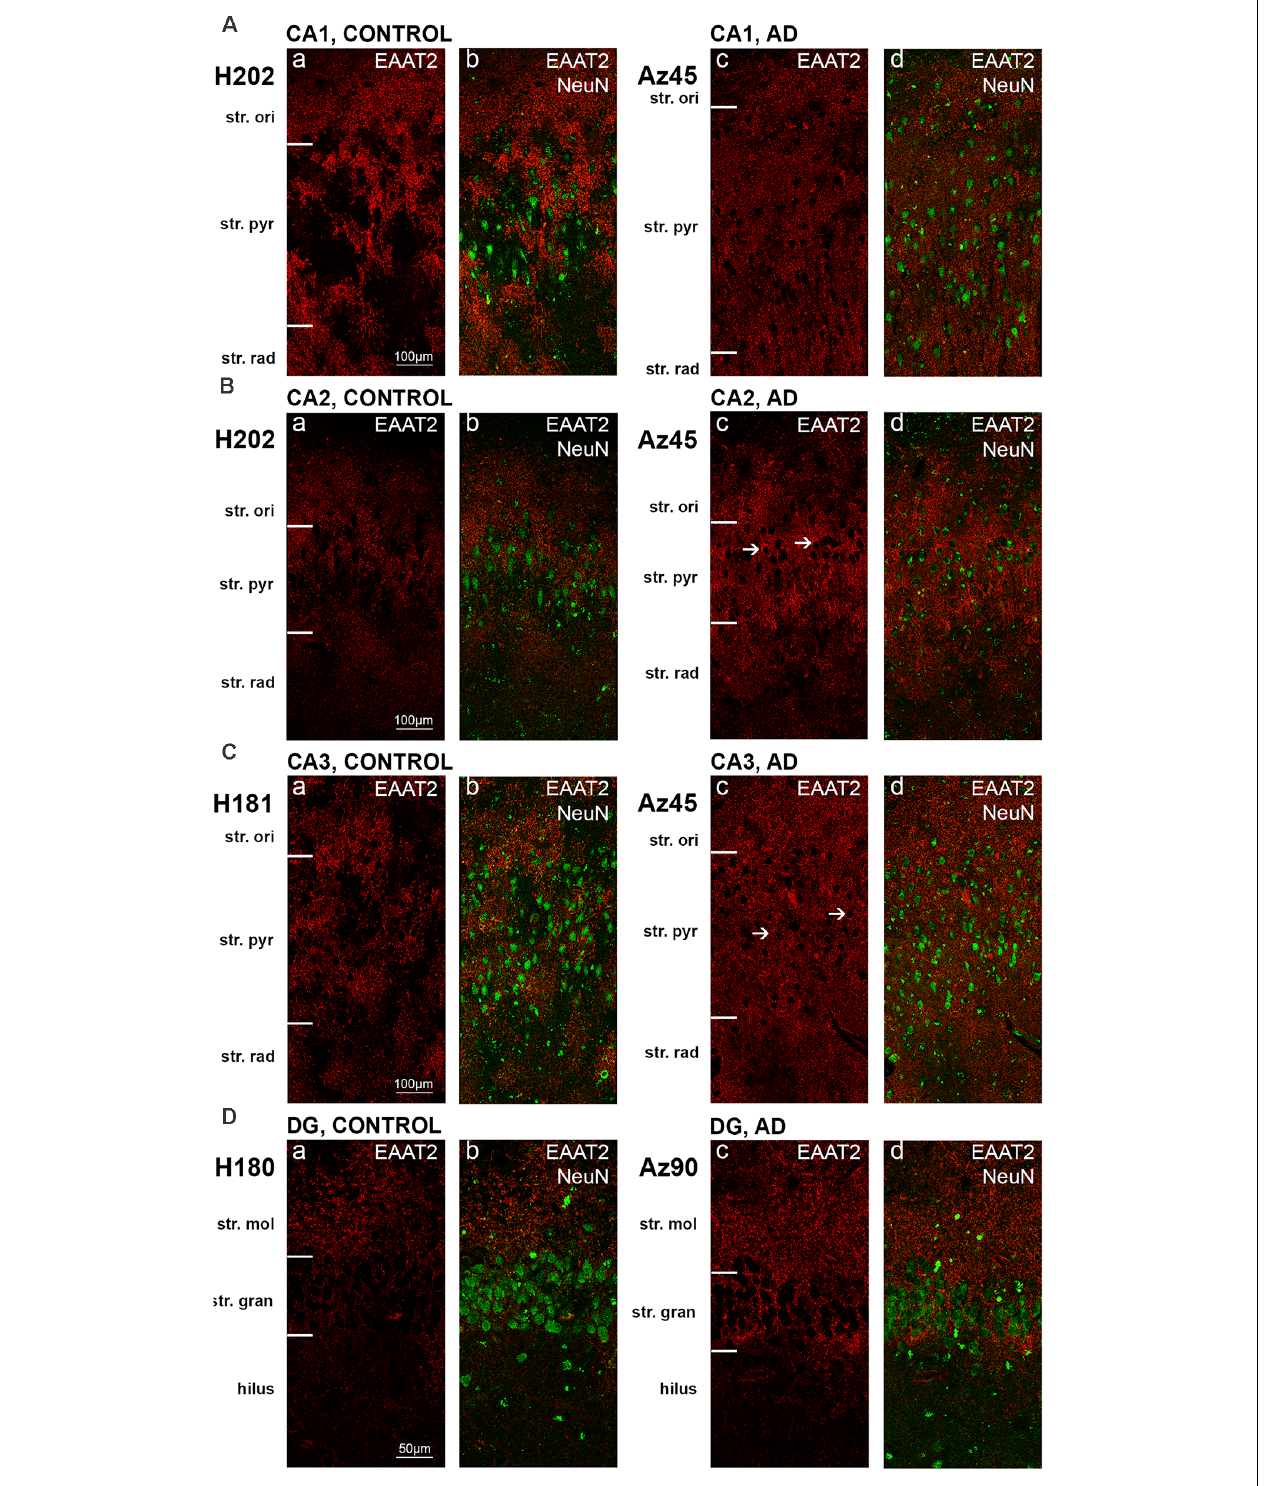
FIGURE 2 | EAAT2 expression in the hippocampus in human control and Alzheimer’s disease (AD) cases visualized by fluorescent immunohistochemistry. Photomicrographs of representative regions of the CA1 (A) , CA2 (B) , CA3 (C) , and dentate gyrus (D) showing EAAT2 (red) and EAAT2 overlaid with NeuN (green) immunoreactivity for representative AD and control cases. AD, Alzheimer’s disease; CA, cornu ammonis; DG, dentate gyrus; str. ori, straum oriens; str. pyr, stratum pyramidale; str. rad, stratum radiatum; str. mol, stratum moleculare; str. gran, stratum granulosum. Scale bars (A–C) = 100 µ m; (D) = 50 µ m.